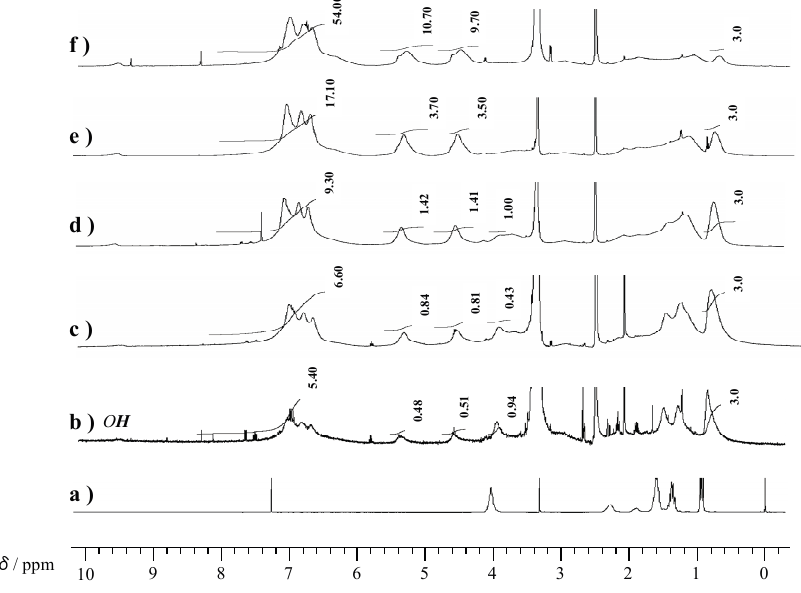
Figure 6. 1 H-NMR spectra of PBuA (a), and P(P-4va/BuA) with 63 (b), 58 (c), 50 (d), 33 (e), and 14 (f) mol % of BuA composition prepared at 90, 70, 50, 30, and 10 mol % of BuA feed ratio,